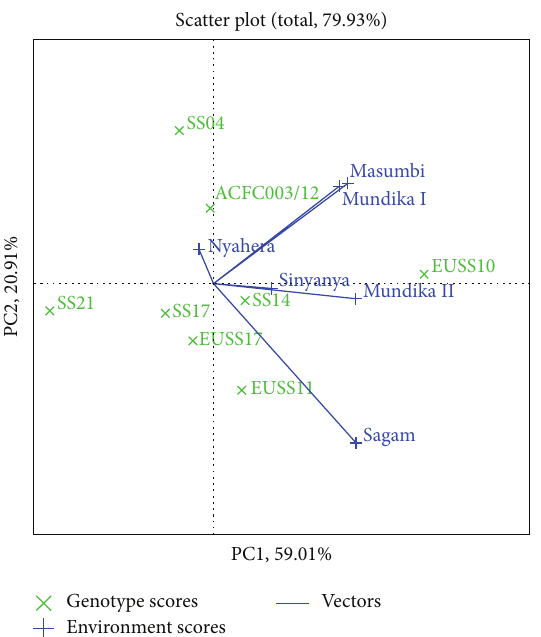
Figure 8: The biplot showing relationship between testers and mega environments for ethanol